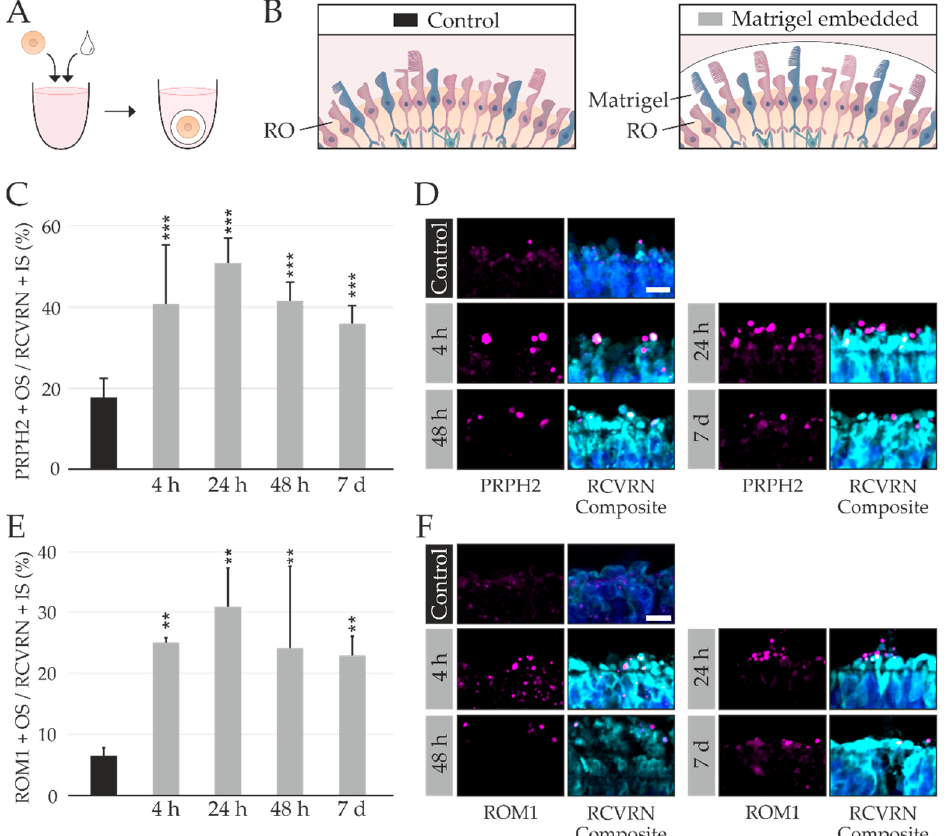
Figure 6. Matrigel embedding protected photoreceptor outer segment (OS) histoarchitecture. ( A ) Diagram of the Matrigel (represented by a white droplet) embedding procedure. ( B ) Schematic representation of photoreceptor OS loss during processing without Matrigel embedding (left image), and improved photoreceptor OS retention in Matrigel ‐ embedded retinal organoids (ROs) (right image). ( C ) The percentage of PRPH2 ‐ positive photoreceptor OS relative to the number of RCVRN ‐ positive photoreceptor inner segments (IS) is shown. ROs embedded in Matrigel for 24 h showed the highest proportion of photoreceptors with preserved OS (51 ± 6.1 % vs. 17.8 ± 4.6 % in control ROs, p = 0.0002). ( D ) Exemplary PRPH2 ‐ and RCVRN ‐ immunostained images quantified in ( C ). ( E ) The percentage of ROM1 ‐ positive photoreceptor OS relative to the number of RCVRN ‐ positive photoreceptors IS is shown. ROs embedded in Matrigel for 24 h showed the highest proportion of photoreceptors with preserved OS (30.9 ± 6.4 % vs. 6.6 ± 1.2 % in control ROs, p = 0.003). ( F ) Exemplary ROM1 ‐ and RCVRN ‐ immunostained images quantified in ( E ) are shown. Counterstaining was performed with Dapi dye. Scale bars: 10 μ m, ** p < 0.01, *** p < 0.001 (Bonferroni ‐ corrected).